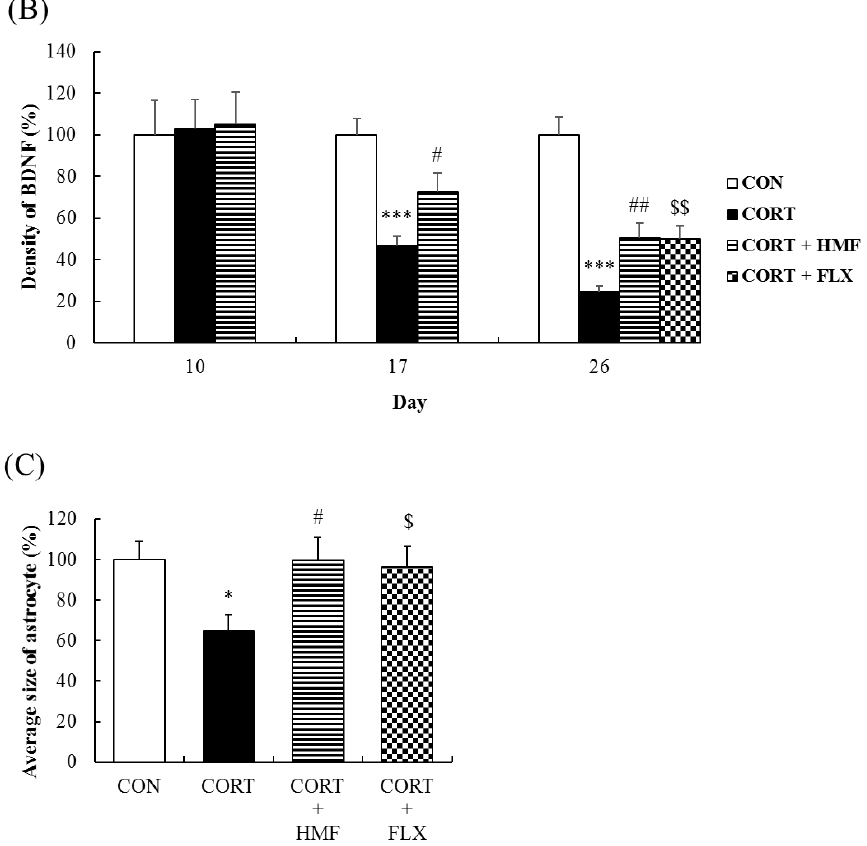
Figure 4. Effects of HMF on the expression of BDNF and GFAP immunoreactivity in the corticosterone-induced depressive mouse hippocampus. (A) Sagittal sections on Day 26 after continuous corticosterone injections were stained with specific antibodies, either anti-BDNF (green; a, b, c, d) or anti-GFAP with DAPI staining (red and blue, respectively; f, g, h, i). Each signal was merged in k, l, m and n, respectively. White squares in the CON group showed a typical astrocyte expressing BDNF, and each high-power magnification picture was shown as e, j, and o. The white and the pink scale bar show 50 µm and 25 µm, respectively. The location of the captured images in the hippocampus and quantification is shown with a square (0.22 mm 2 ). ( B ) A quantitative analysis of BDNF-positive signal densities using ImageJ software. Values are means ± SEM (Day 10; n = 4, Day 17; n = 8, Day 26; n = 8–10). Symbols show significant differences between the following conditions: CON vs. CORT (*** p < 0.001), CORT vs. CORT + HMF ( # p < 0.05, ## p < 0.01), and CORT vs. CORT + FLX ( $$ p < 0.01). A quantitative analysis of the average size ( C ) of GFAP-positive signals on Day 26 using ImageJ software. Values are means ± SEM ( n = 8–10). Symbols show significant differences between the following conditions: CON vs. CORT (* p < 0.05), CORT vs. CORT + HMF ( # p < 0.05), and CORT vs. CORT + FLX ( $ p < 0.05).